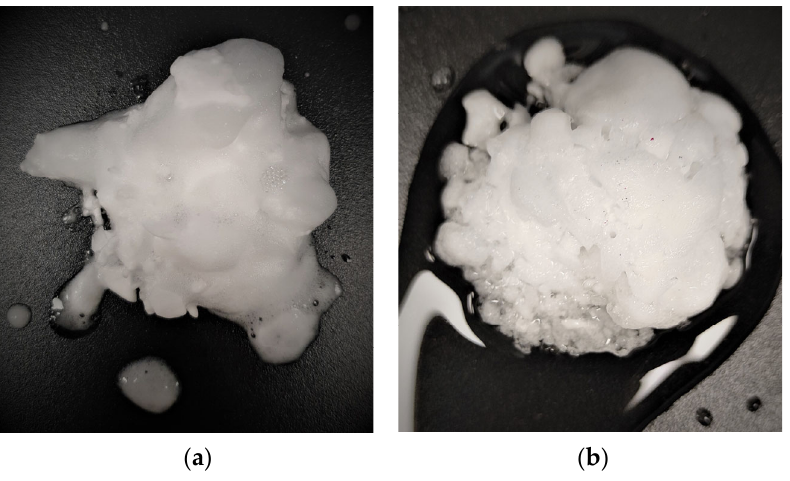
Figure 5. Exterior view of methane hydrate after regasification for samples: ( a ) SDS; and ( b ) 2d .